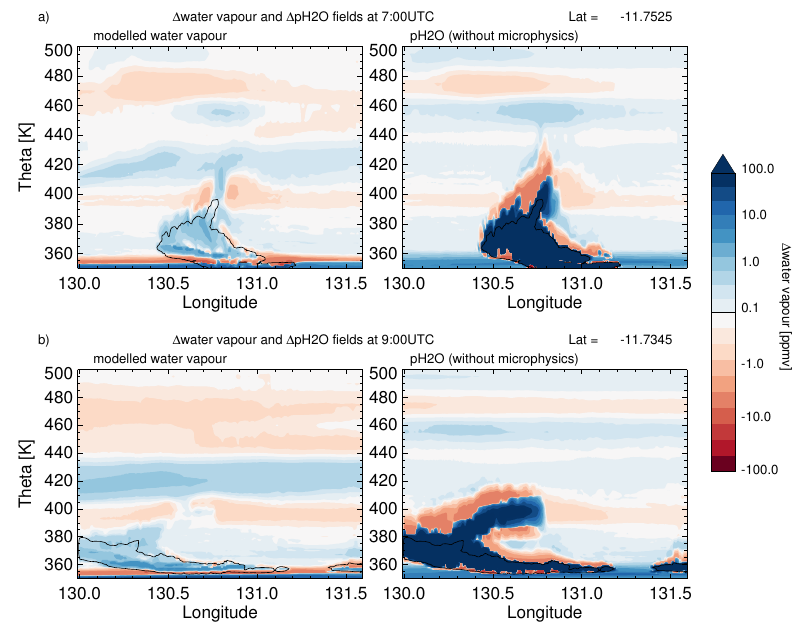
Figure 14. Same as Fig. 13 but for 07:00UTC (a) and 09:00UTC (b)